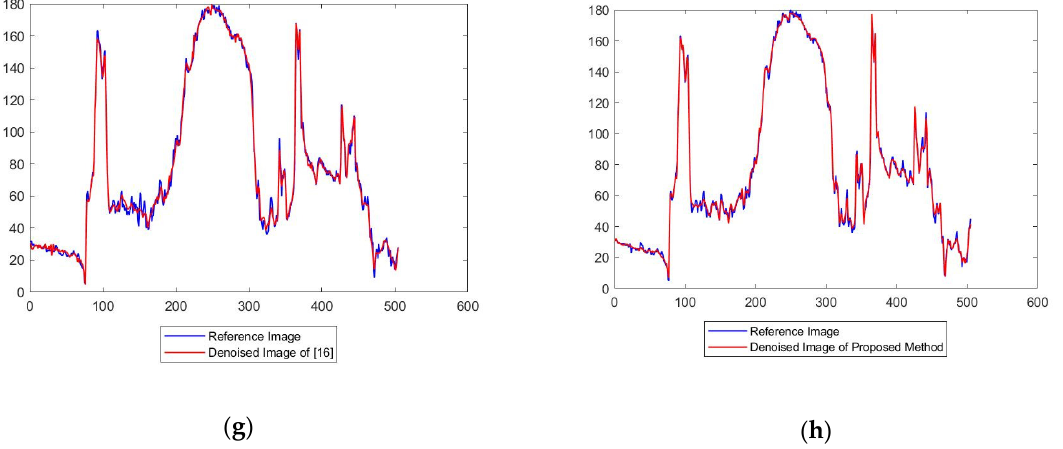
Figure 9. Intensity profiles of the original image against the [10–16] framework and the proposed framework, respectively; ( a ) Intensity profile between reference image and denoised image [10]; ( b ) Intensity profile between reference image and denoised image [11]; ( c ) Intensity profile between reference image and denoised image [12]; ( d ) Intensity profile between reference image and denoised image [13]; ( e ) Intensity profile between reference image and denoised image [14]; ( f ) Intensity profile between reference image and denoised image [15]; ( g ) Intensity profile between reference image and denoised image [16]; ( h ) Intensity profile between reference image and denoised image of proposed method.